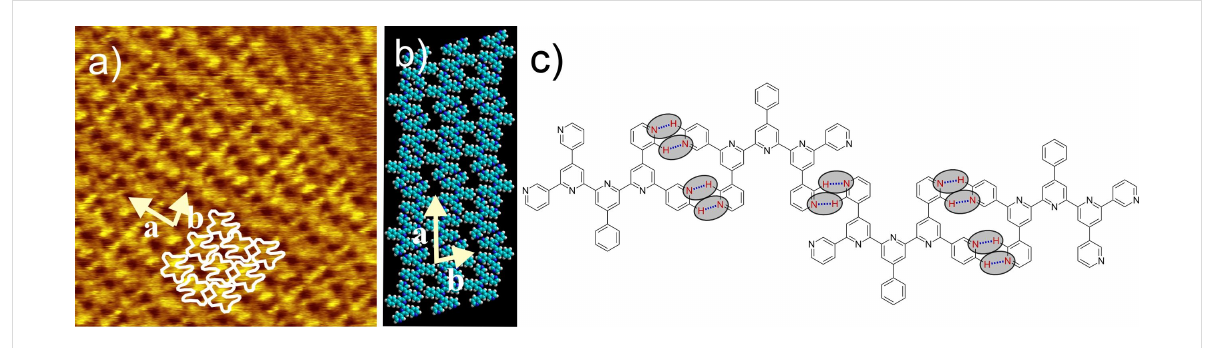
Figure 7: a) 15 × 15 nm 2 STM image ( I set = 14.5 pA, V set = − 610 mV) of 3,3'-PhSpPy ( 15 ) at the HOPG/TCB interface [ a = 2.7 ± 0.2 nm, b = 1.6 ± 0.2 nm, a,b = 77 ± 2°] overlaid with nine molecules; b) model of the 3,3'-PhSpPy ( 15 ) lamellar pattern; c) hydrogen bonding motif of 3,3'-PhSpPy ( 15 ); the hydrogen bonds are marked by ovals.